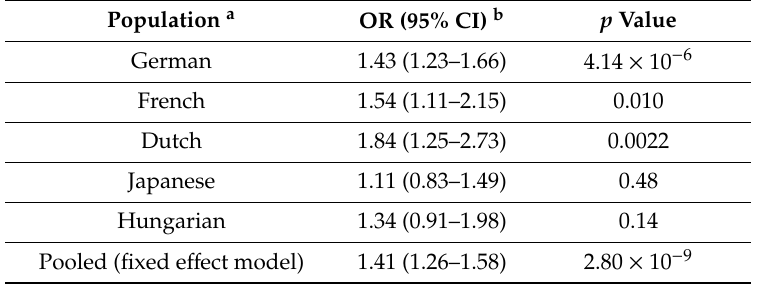
Table 5. Estimation of gene-environment interaction between the common PRSS1-PRSS2 haplotype and alcohol consumption using a case-only